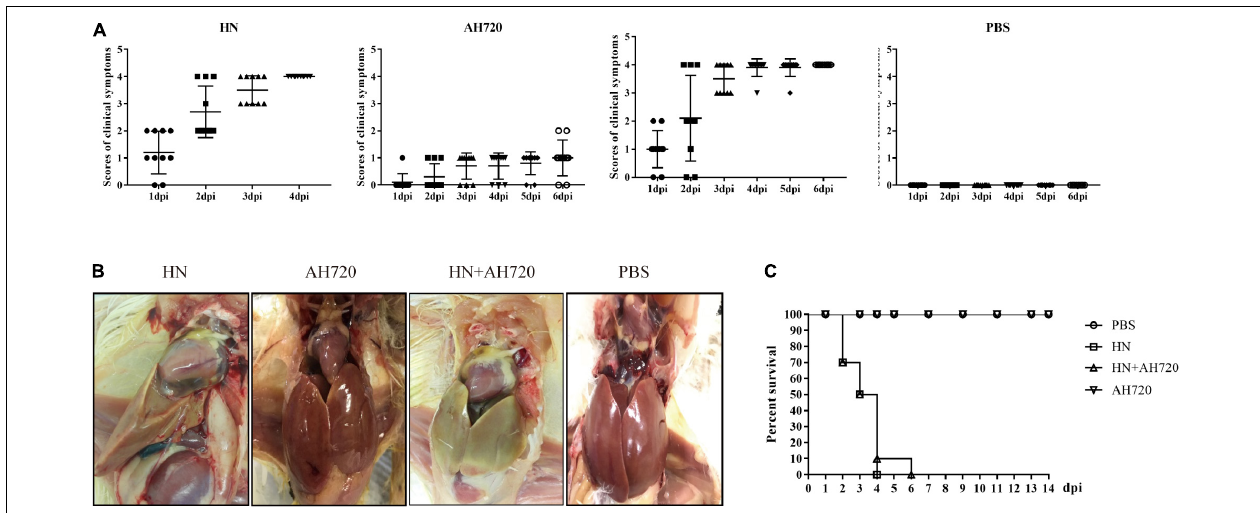
FIGURE 1 | Pathogenicity of chickens from different infection groups. (A) Clinical scores of chickens in four different infection groups. Chickens were randomly divided into four groups and challenged with HN strain (group I), AH720 strain (group II) and a mixture of HN and AH720 strains (group III), and PBS (group IV). Clinical scoring: 0 for normal, 1 for mild depression, 2 for severely depressed, 3 for paralysis/prostration, and 4 for death. (B) Gross lesions of chickens in four different infection groups. The livers of chickens from groups I and III both showed enlarged yellow and pericardial effusion. A chicken in group II showed a liver with hemorrhages and a chicken from group IV showed a normal liver. (C) Survival rate of the chickens in four different groups. No death was found in the chickens infected with AH720 strain. The mortality rate of chickens challenged with HN strain reached 100% within 4 days post-challenge. However, 100% mortality rate in chickens from group III was within 6 days when co-infected with HN and AH720